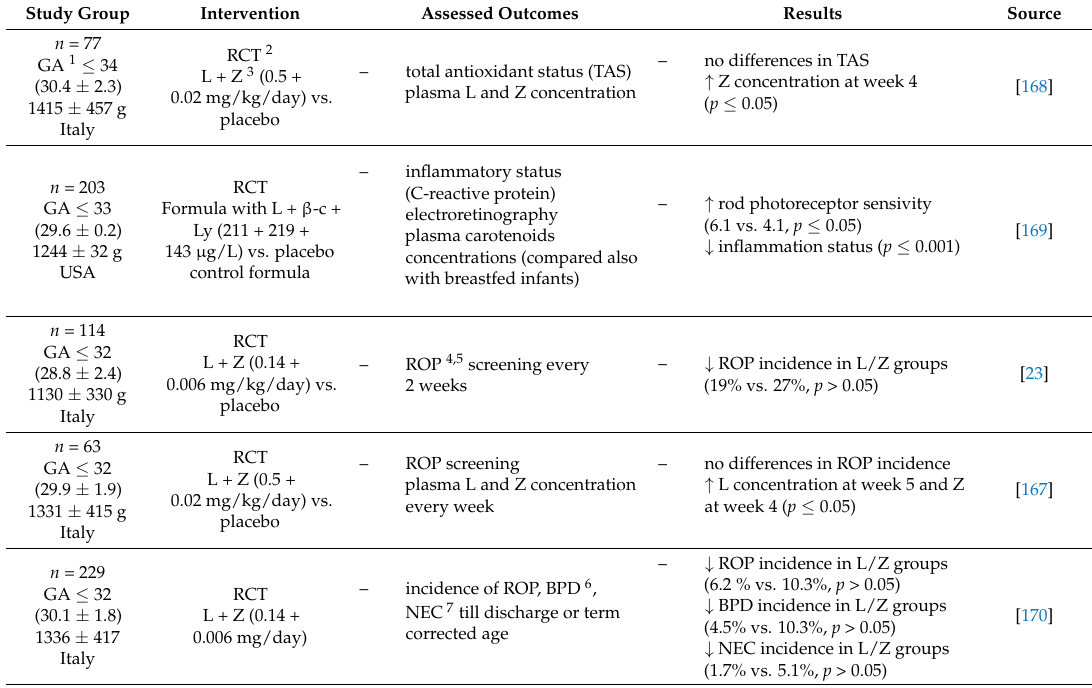
The impact of carotenoids supplementation on oxidative stress and occurrence of prematurity